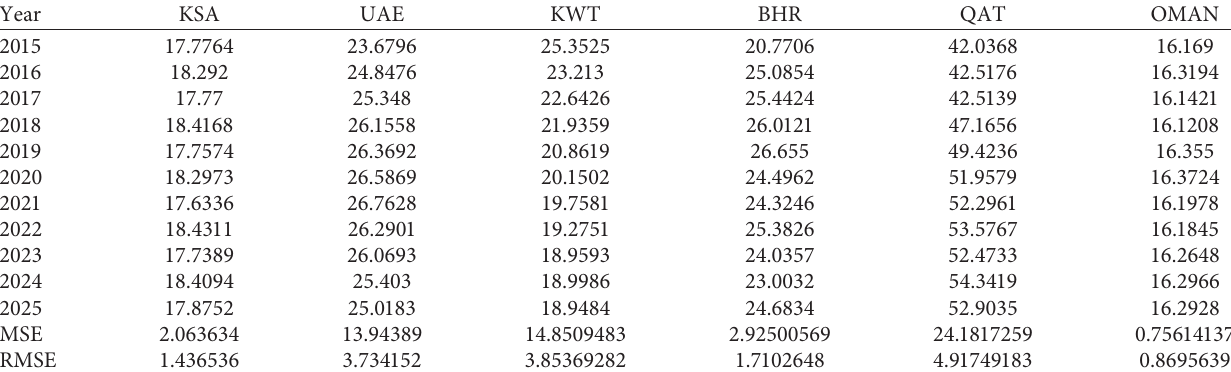
Table 4: Predicted value of CO 2 emissions (metric tons per capita) using the ANN model and accuracy measures.